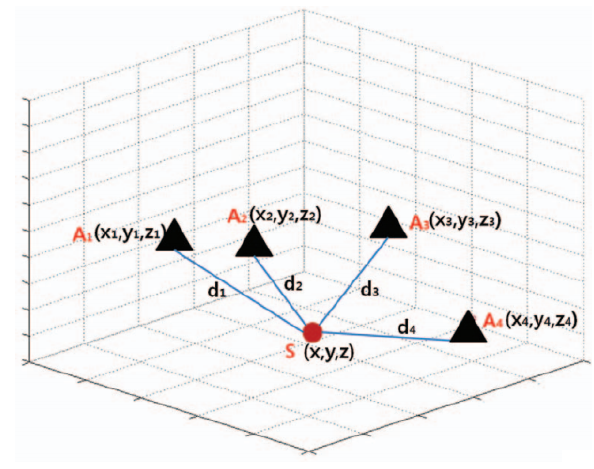
Figure 3. 3D trilatateration